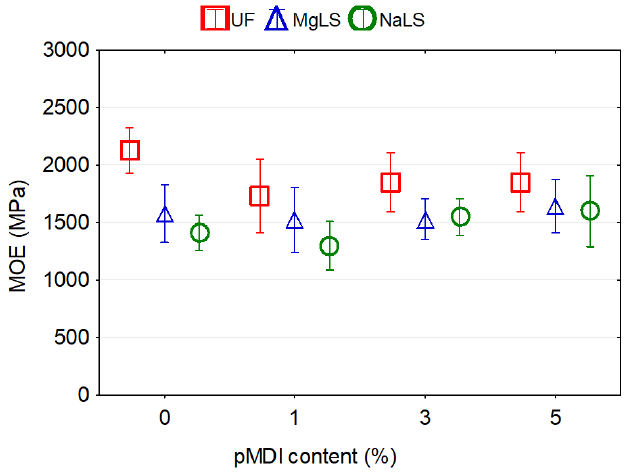
Figure 11. Effect of pMDI content on the bending strength of particleboards bonded with pure UF and lignosulfonate adhesives.